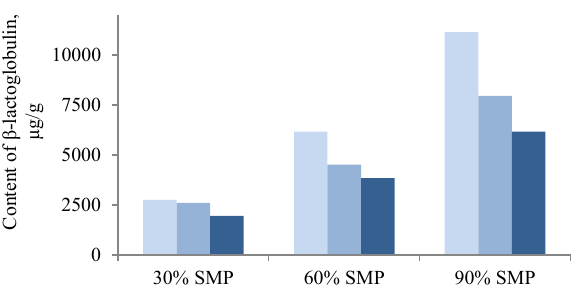
Figure 2 Content of β-lactoglobulin in the sourdoughs various yeast strains after fermentation